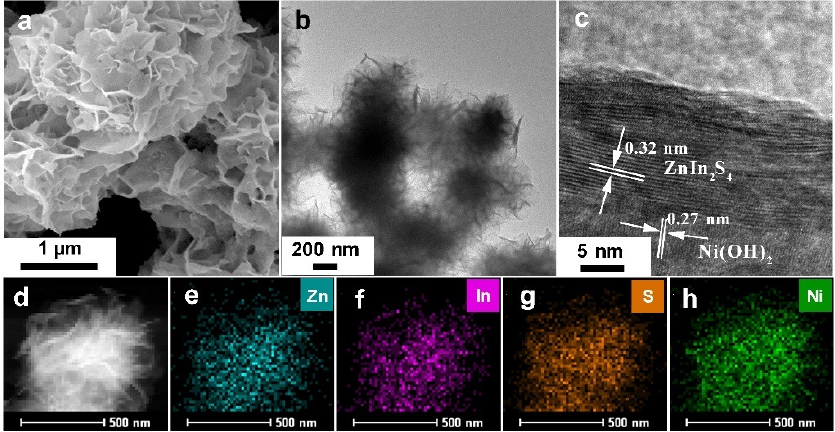
Figure 2. SEM image ( a ), TEM image ( b ), HRTEM image ( c ), HAADF-STEM image ( d ), and elemental mapping images ( e – h ) of 0.37 wt% Ni(OH) 2 /ZnIn 2 S 4 composite.